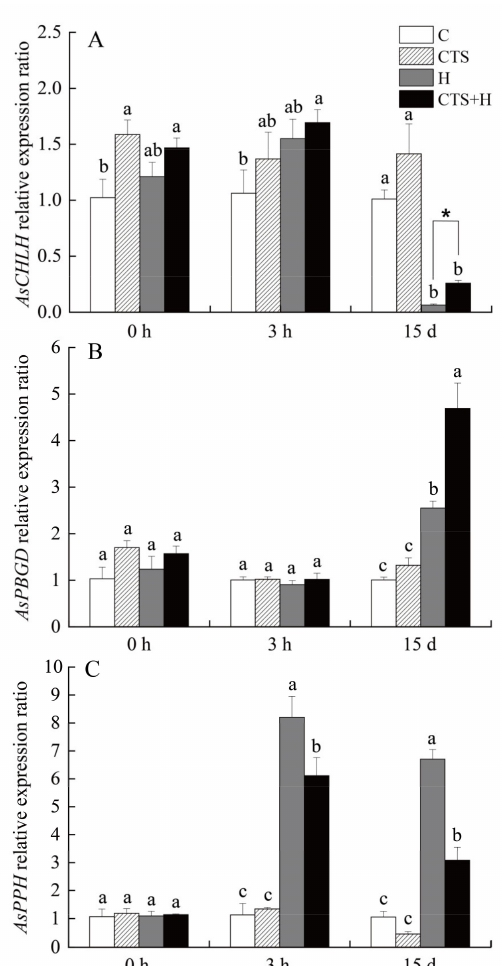
Figure 4. Effect of chitosan on ( A ) AsCHLH , ( B ) AsPBGD , and ( C ) AsPPH relative expression in